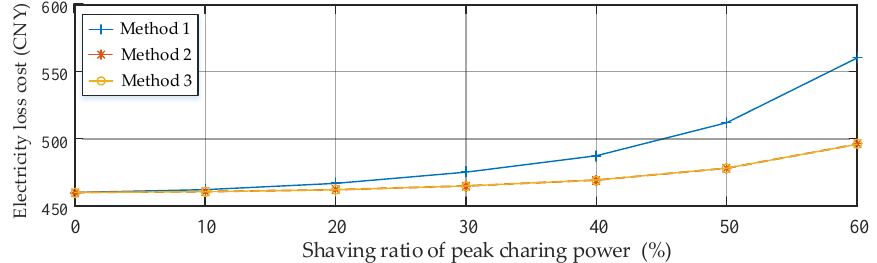
Figure 9. Electricity loss cost of three scenarios with different shaving ratios of peak charging power.